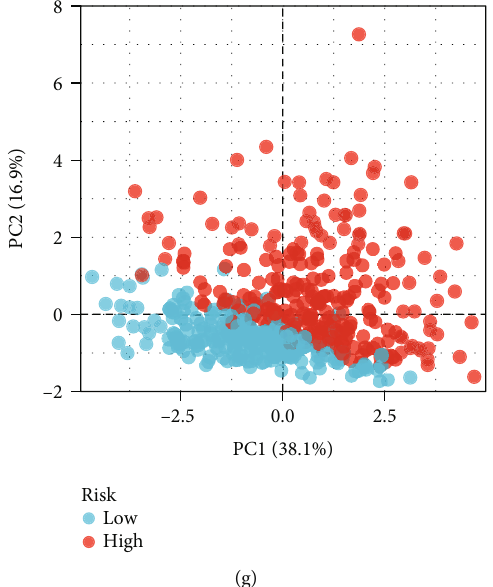
Figure 2: De fi nition of a cuproptosis-relevant lncRNA signature for LUAD. (a) Interactions of cuproptosis genes with lncRNAs across LUAD under the criteria of ∣ correlationefficient ∣ >0 : 4 and p value < 0.0001. (b) Forest diagram visualizing the prognostic cuproptosis- relevant lncRNAs. (c) Partial likelihood deviance under diverse log ð λ Þ values for LASSO. (d) LASSO regression coe ffi cients under diverse log ð λ Þ values. (e) LASSO regression coe ffi cients of each prognostic cuproptosis-relevant lncRNA. (f) Distribution of risk score derived from the cuproptosis-relevant lncRNA signature, survival time and status, and expression levels of prognostic cuproptosis- relevant lncRNAs. (g) PCA plots visualizing the di ff erence between low- and high-risk subsets at the transcriptional